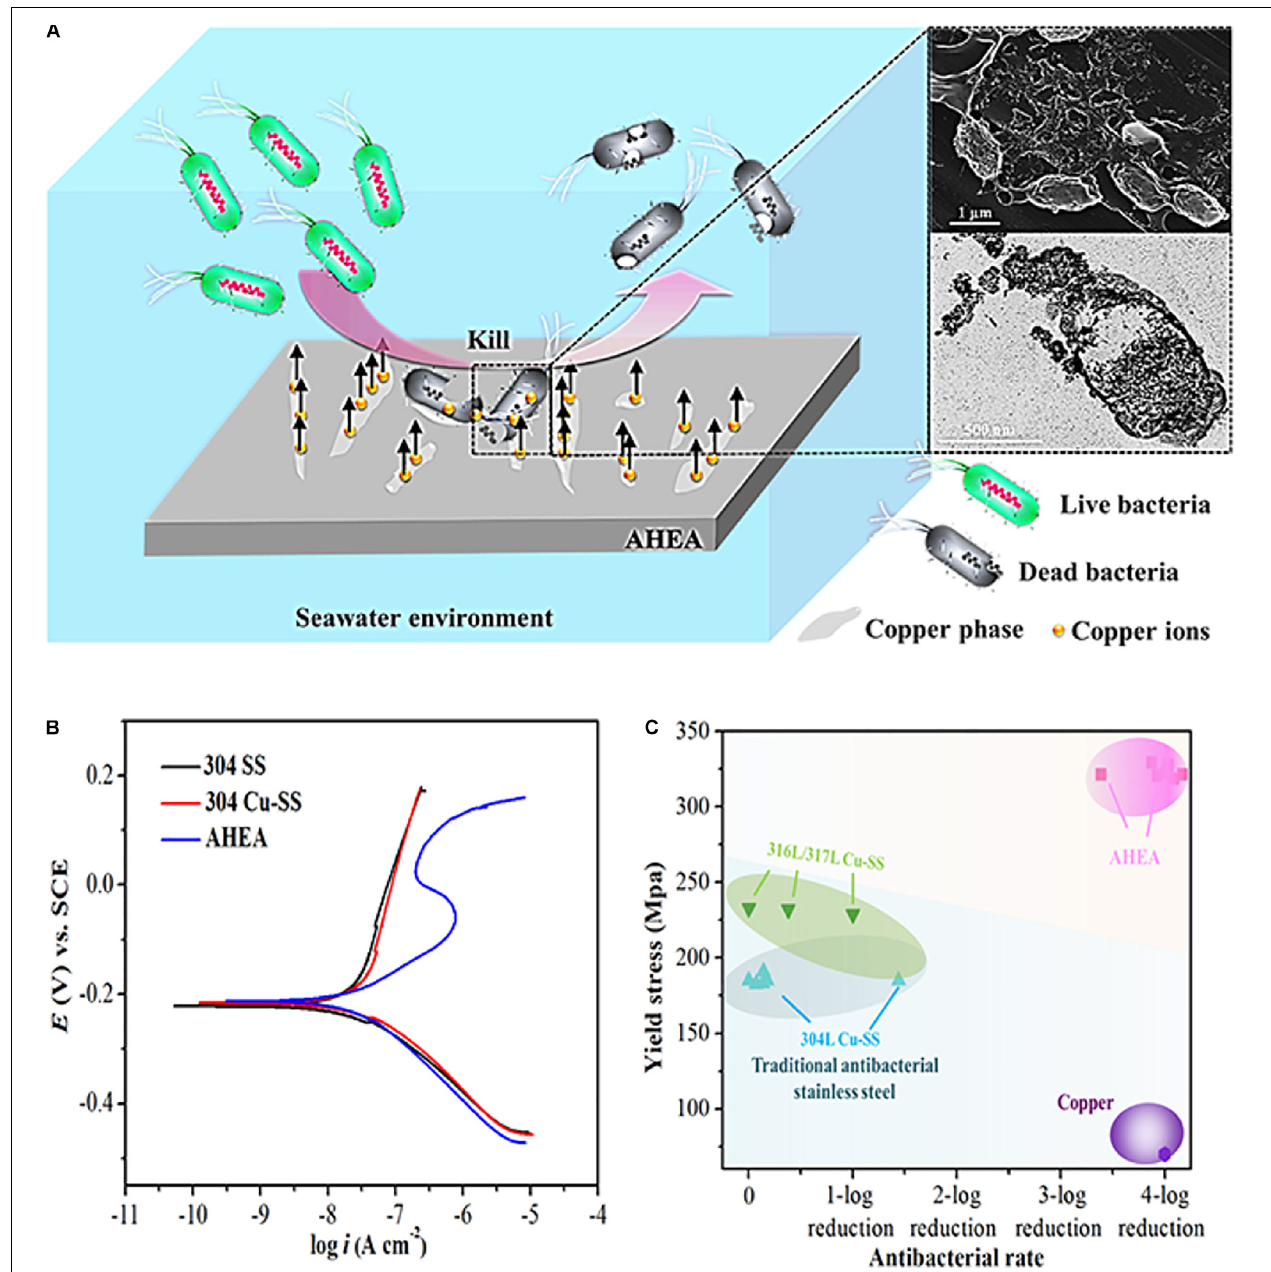
FIGURE 9 | (A) Schematic illustration for the antimicrobial mechanism of AHEA, (B) polarization curves of 304 SS, 304 Cu-SS, and AHEA in the simulated seawater and (C) yield stresses and antibacterial rates (Zhou et al., 2020). Reproduced from Zhou et al. (2020) with